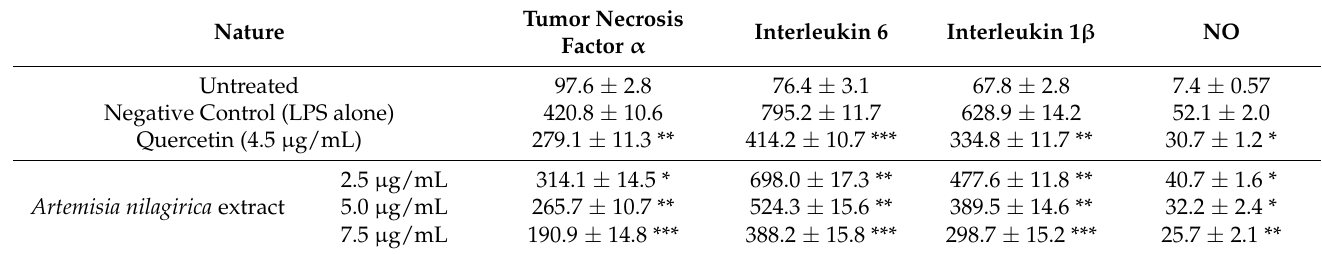
Table 8. Effect of the Artemisia nilagirica leaf ethanol extract (AN) against lipopolysaccharide-induced macrophage (Raw 264.7) activation, cytokine release (in pg/mg protein), and nitric oxide production ( µ M/mg